Question: Provide a one-line summary of what is displayed.
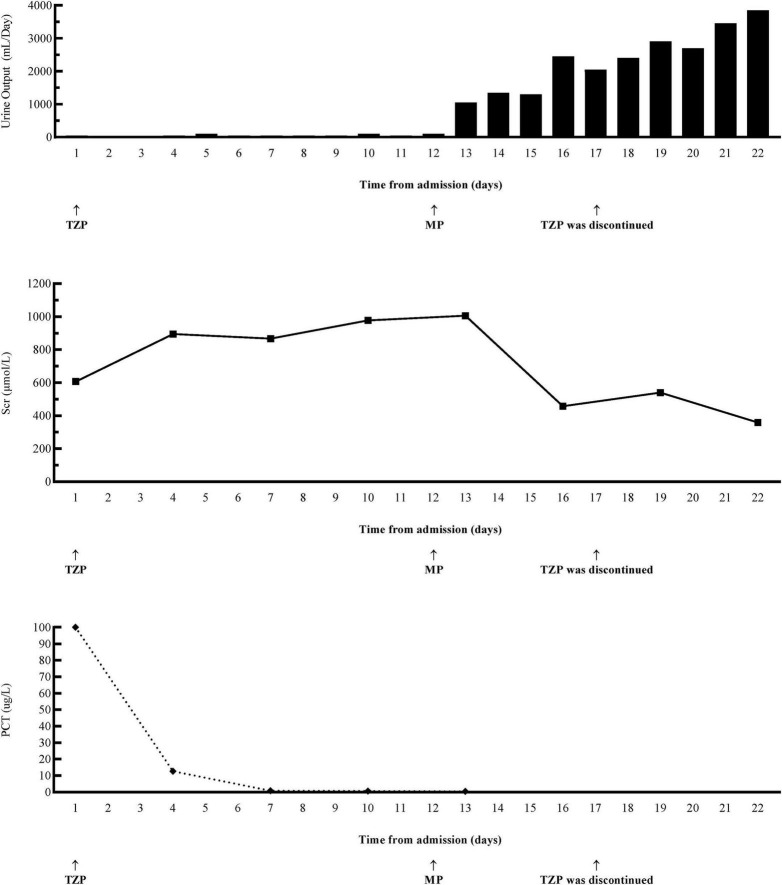
Answer: Changes in urine output and laboratory test results within 24 h during the patient’s hospitalization. Scr, Serum creatinine, PCT, procalcitonin, TZP, piperacillin/tazobactam 4.5 g, IV/12 h, MP, Methylprednisolone 40 mg, IV/day.